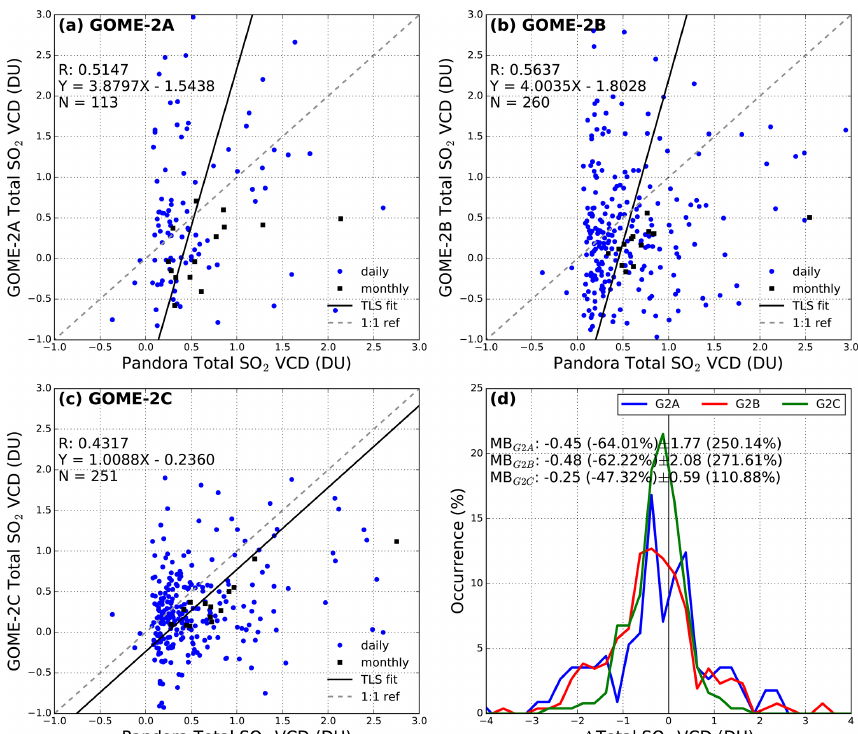
Figure 26. Comparison of daily and monthly total column SO 2 measured by the Pandora instrument in Mexico City to (a) GOME-2A, (b) GOME-2B, and (c) GOME-2C. Histograms of the difference in total column SO 2 between GOME-2 and Pandora observations are shown in panel (d) . Co-located daily and monthly averaged data are used in the comparison. Total least-squares regression is based on daily data.